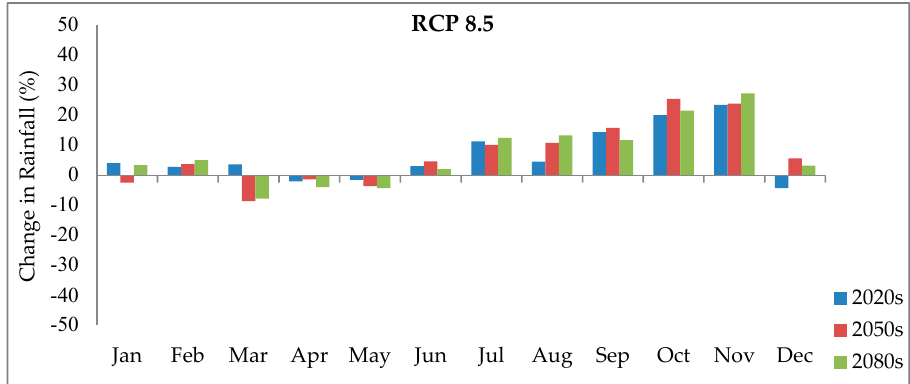
Figure 8. Change in rainfall under RCP4.5 scenario compared to the baseline (1961–1990).